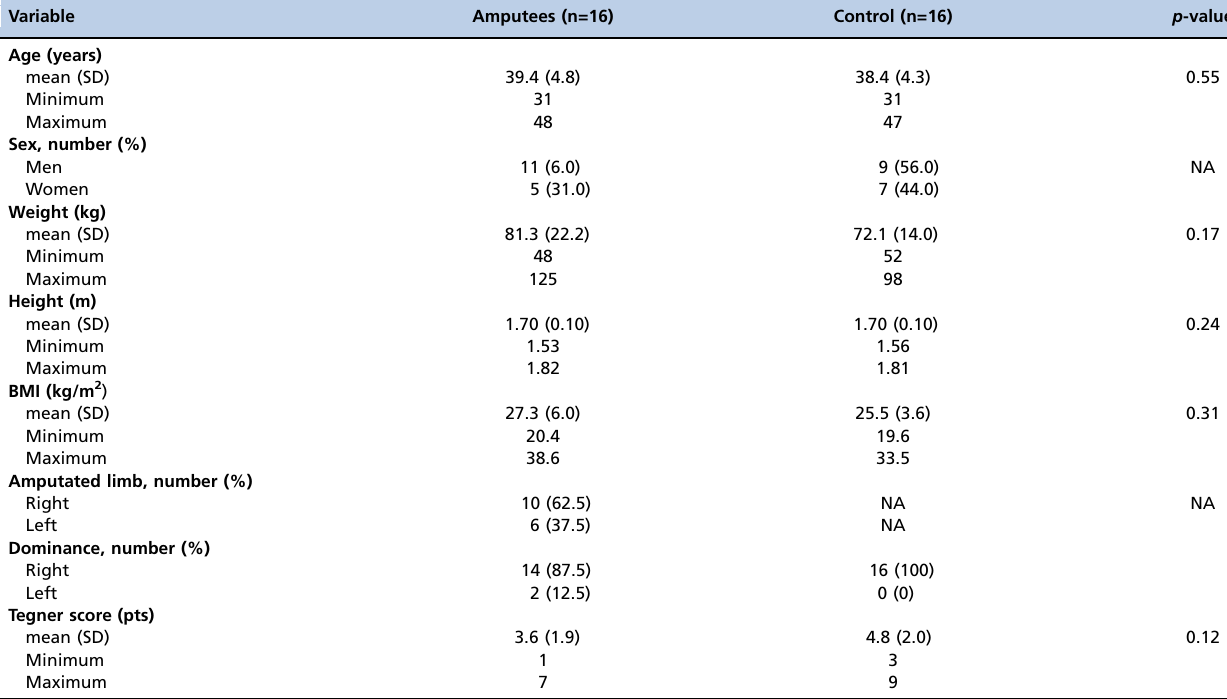
Table 1 - Demographic characteristics of the amputees and control groups.